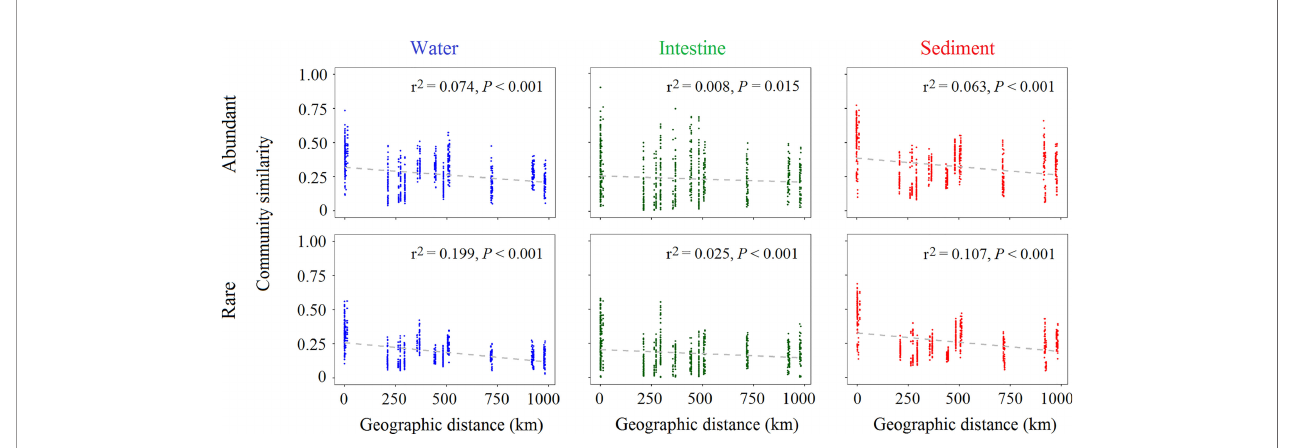
FIGURE 3 | The Spearman ’ s rank correlations between the community similarity of abundant or rare microbial taxa and geographic